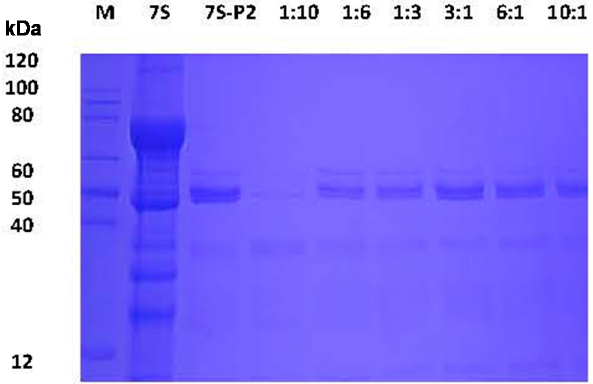
Figure 8. SDS-PAGE analyses of the digestive stability of soy protein 7S in the absence and presence of PCA at different concentrations in simulated intestinal fluid (pH 7.5). Conditions: [soy protein 7S] = 3 µ M; the ratio of protein to phenolic acid: 1:10, 1:6, 1:3, 3:1, 6:1 and 10:1. “7S-P2” represents a mixture of trypsin and soy protein 7S in the absence of phenolic acids.